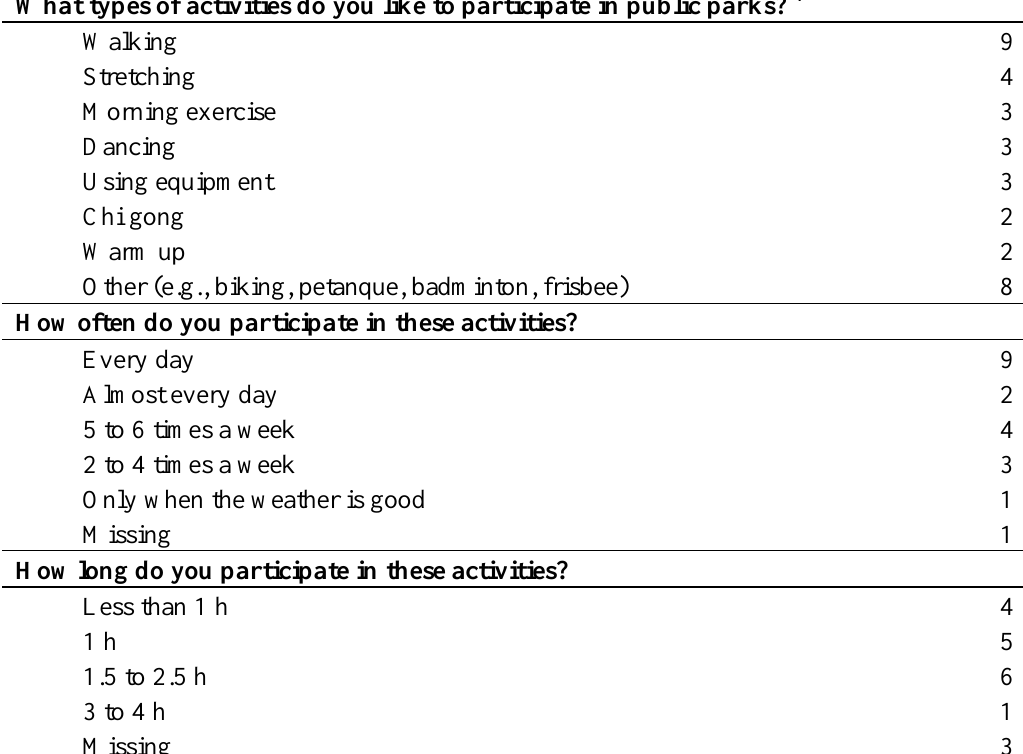
Table 7. Summary of direct responses to interview questions ( n =